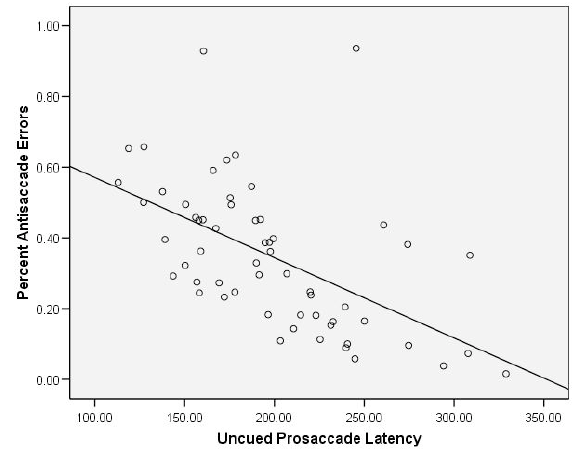
Figure 6. Correlation of pro saccade correct latencies and antisaccade